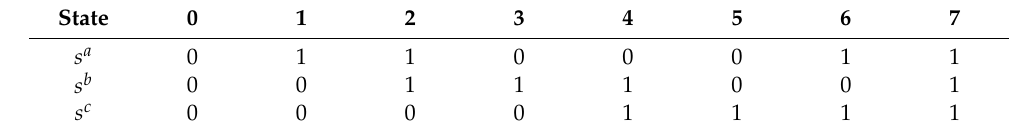
Table 1. Switching states AFE rectifier.